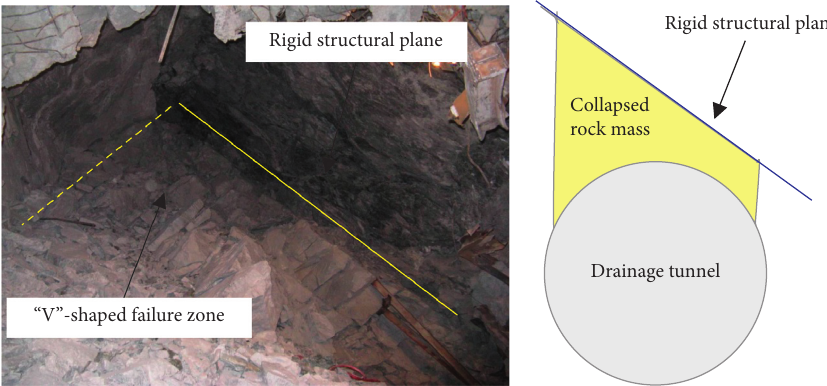
Figure 1: The 11.28 rockburst in drainage tunnel and exposed rigid structural plane